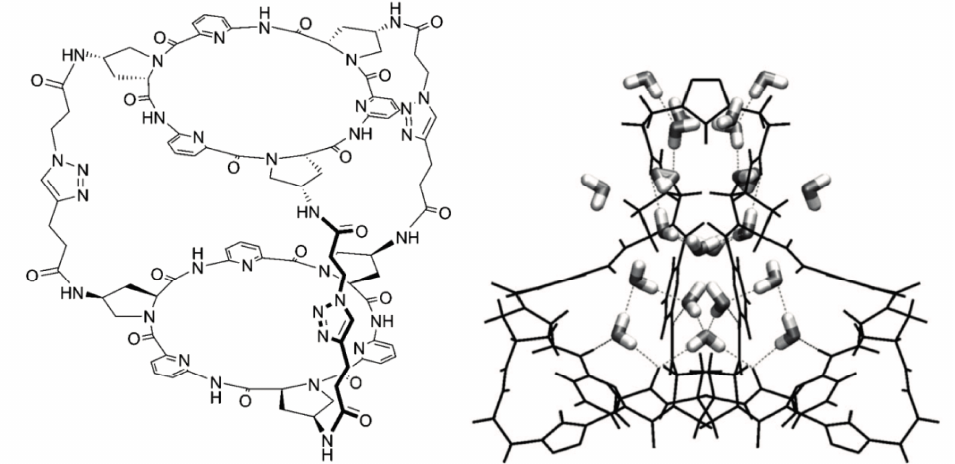
Figure 17. A triply linked bis-cyclopeptide complexing in aqueous solution with high efficiency sulfate ions inside the cavity; in the crystal (right side) only water, no sulfate, is found inside [67]. Adapted from ref. [67] with permission from